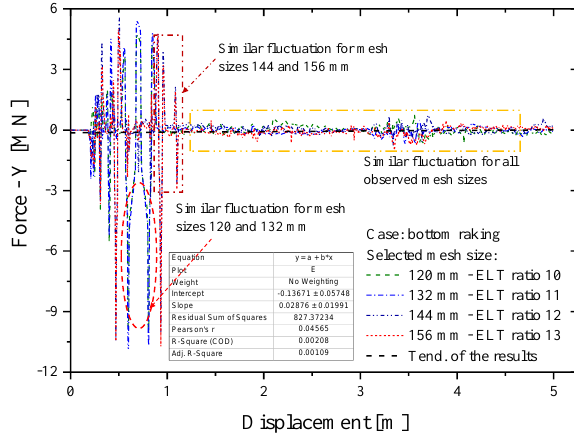
Figure 10. Trend line of the crushing force on the longitudinal (X) direction. Figure 10: Trend line of the crushing force on the longitudinal (X) direction